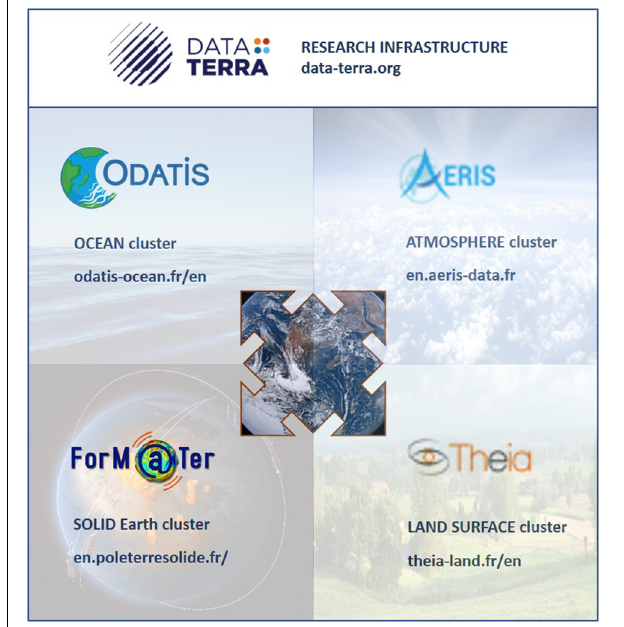
FIGURE 1 | Data Terra research infrastructure for Earth data and its four thematic clusters.